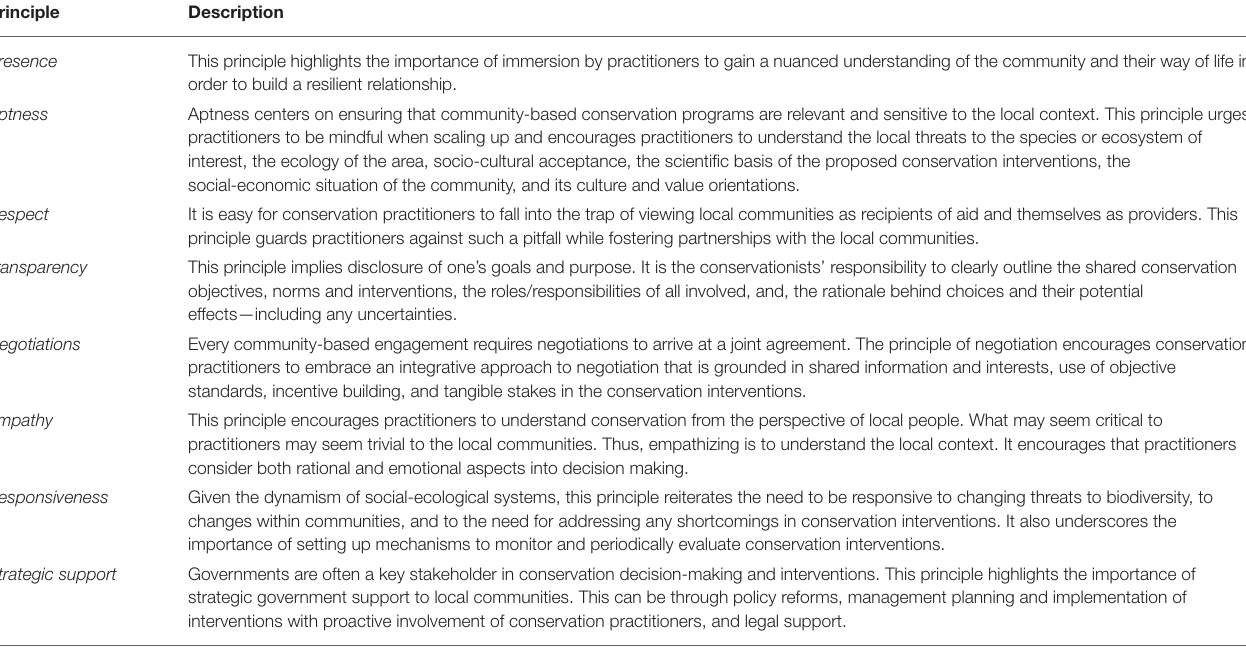
TABLE 1 | The eight PARTNERS principles for effective implementation of community-based programs as defined by Mishra et al. (2017).